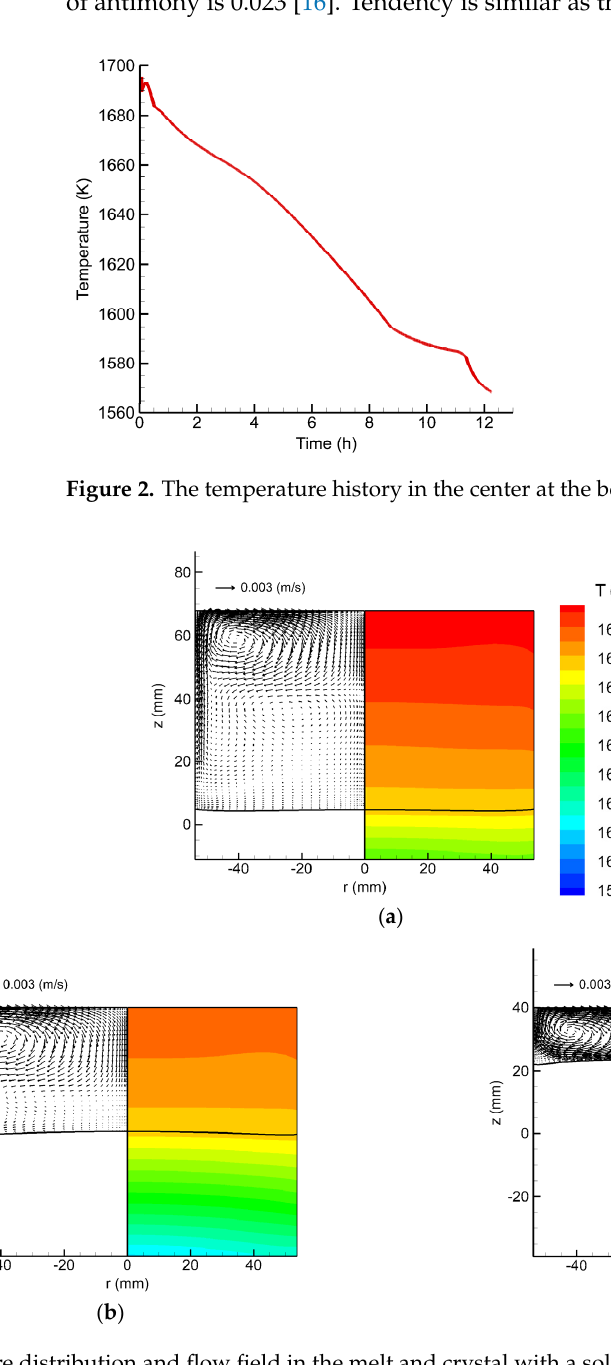
( c ) Figure 4. Distribution of phosphorus concentration in the crystal. The phosphorus evaporation flux at the melt surface was (i) 0 ( a ), (ii) the same as the phosphorus incorporation flux at the melt–crystal interface ( b ), and (iii) twice as large as that of case (ii) ( c ).